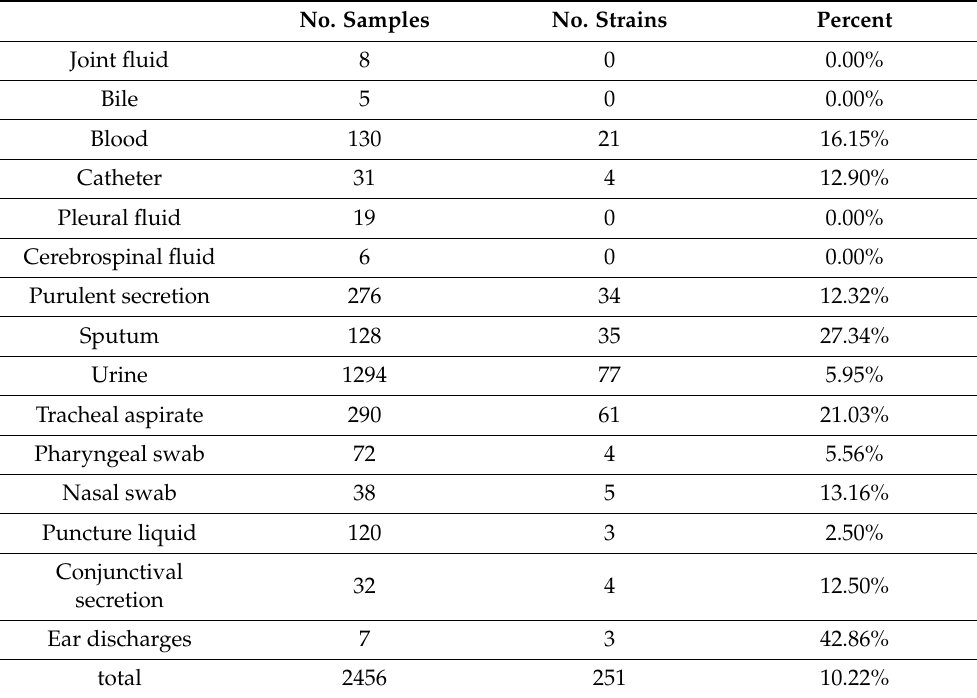
Table 1. The prevalence of Klebsiella strains in the various clinical specimens.